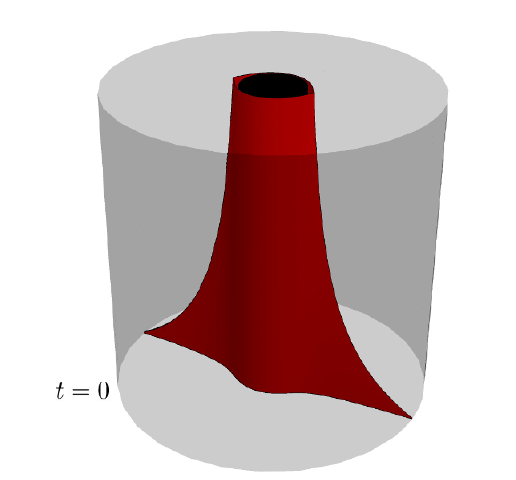
Figure 6 . Creation of the black hole by colliding particles in BTZ coordinates. Red surfaces are the faces of identi(cid:12)cation W (cid:6) introduced by colliding particles. As particles move towards one another, they asymptotically approach the black hole horizon, showed as the black cylinder (which is obscured behind the identi(cid:12)cation surfaces) in the